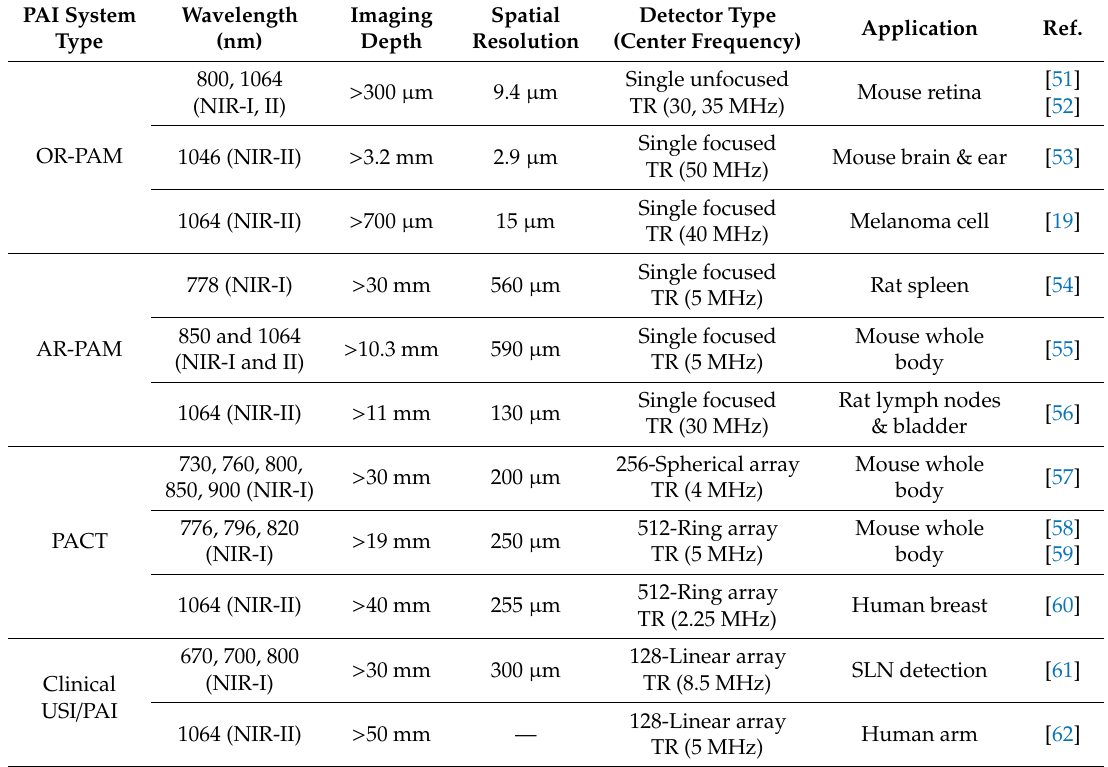
Table 1. Representative photoacoustic imaging (PAI) systems used in near-infrared (NIR)